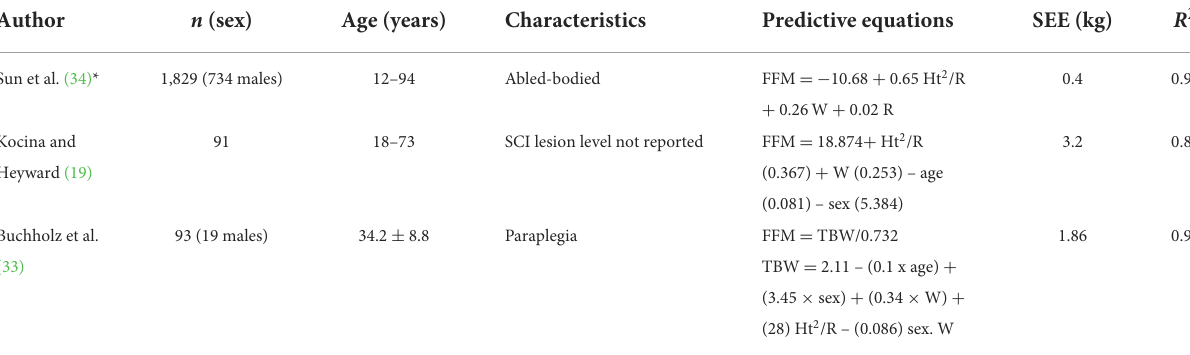
TABLE 1 BIA equations found for the prediction of FFM in SCI individuals and able-bodied people *